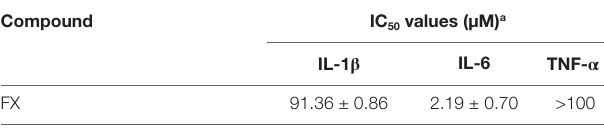
TABLE 1 | Anti-inflammatory effects of FX on LPS-stimulated RAW264.7